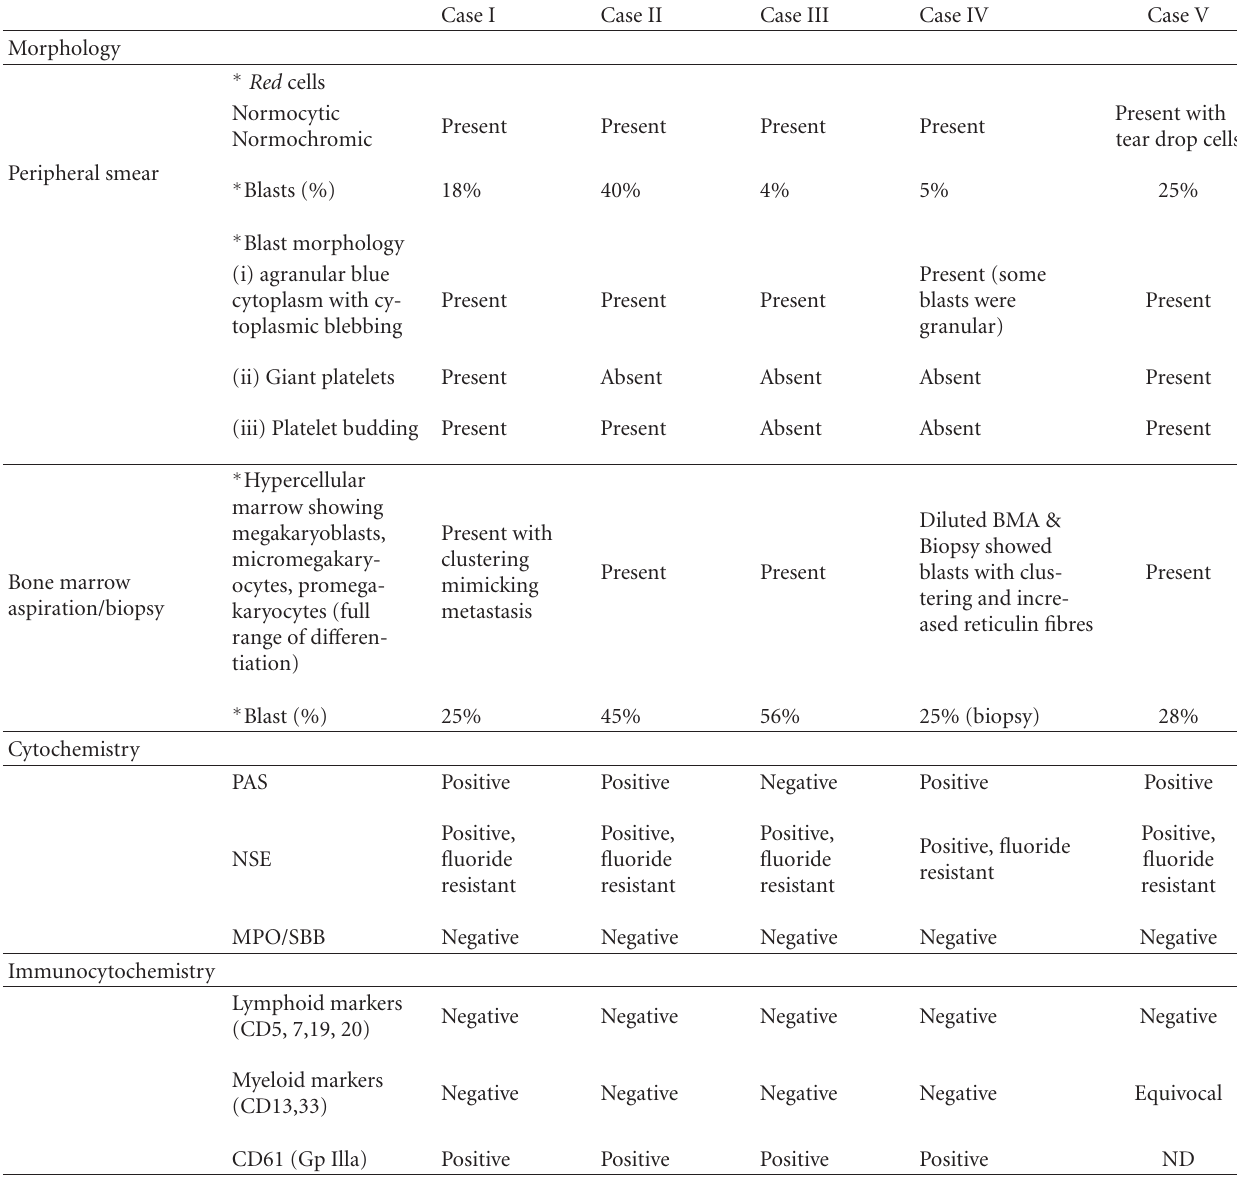
Table 2: Morphology, cytochemistry and